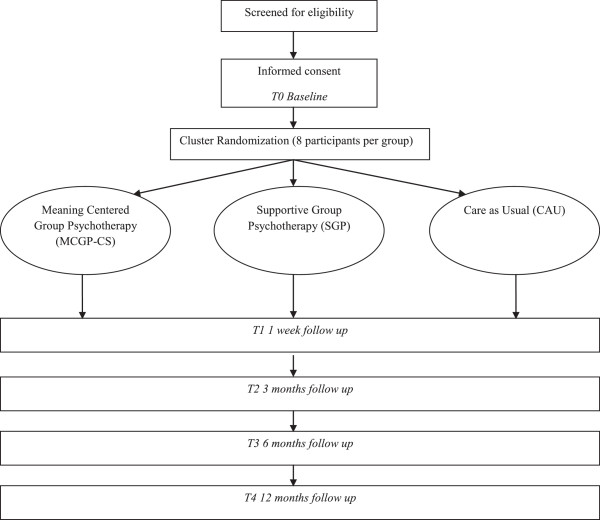
Design of the RCT.